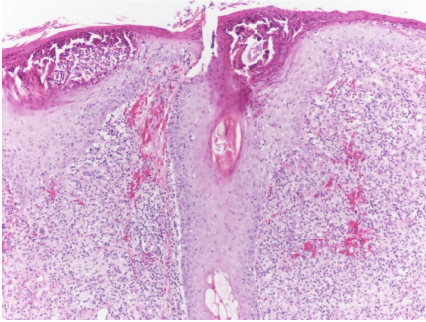
Figure 4: Further magnification highlights the folliculocentric inflammation